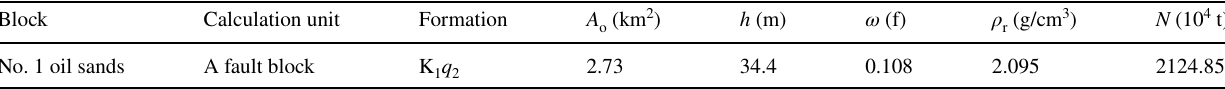
Table 4 Calculation results of geological reserves of crude bitumen in Fengcheng No. 1 oil sands Block Calculation